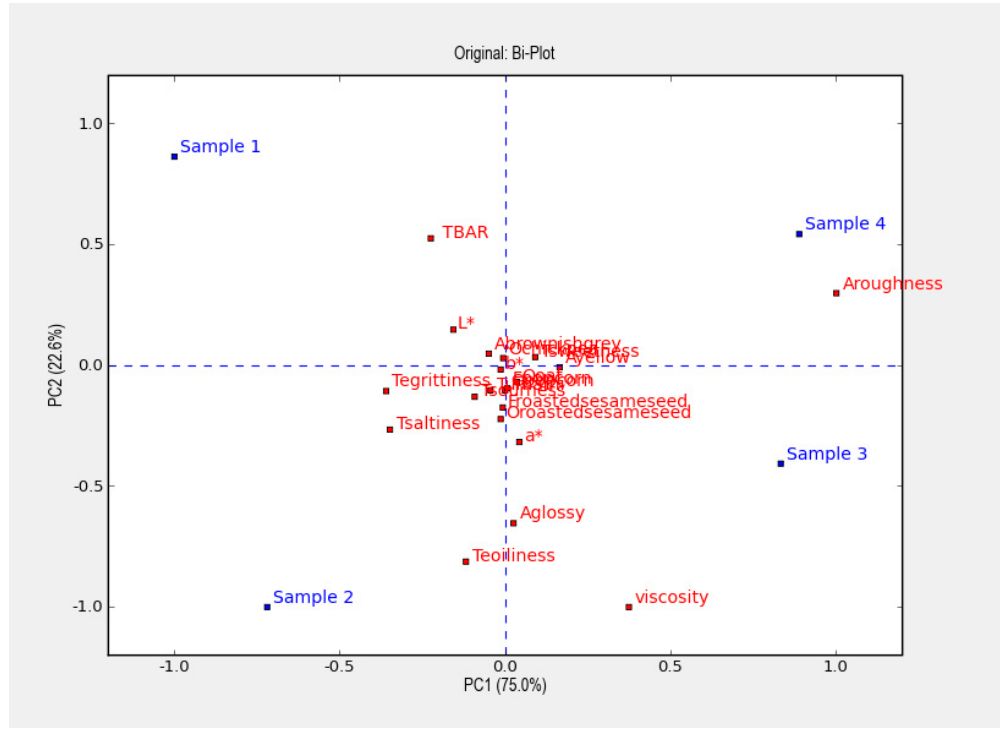
Figure 4. A Principal component analysis (PCA) plot of the four samples.